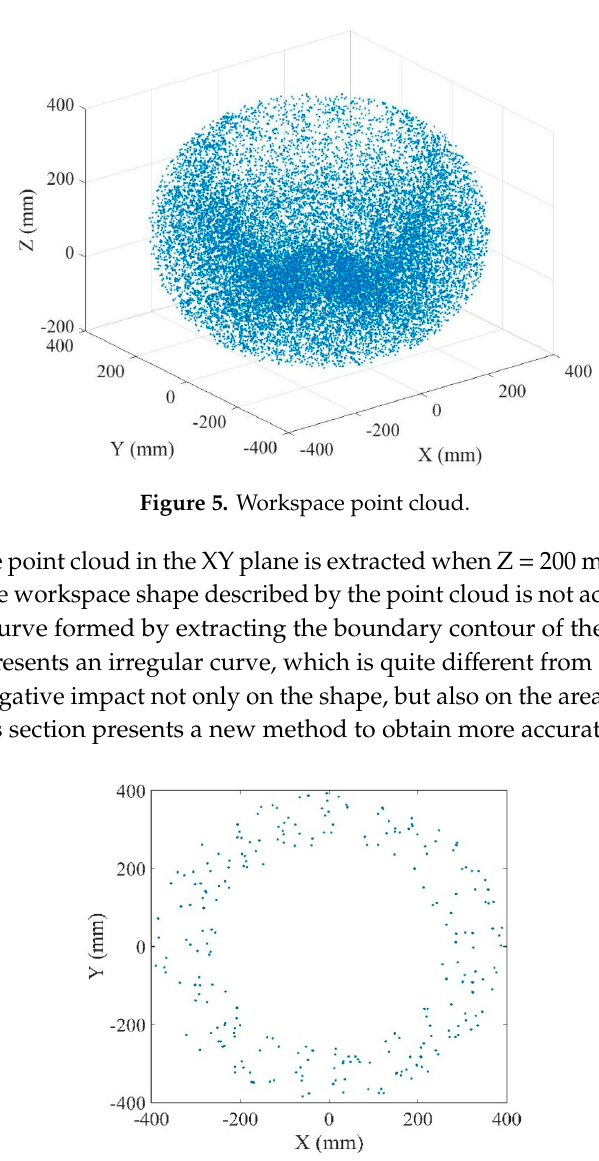
Figure 6. The point cloud in the XY plane.